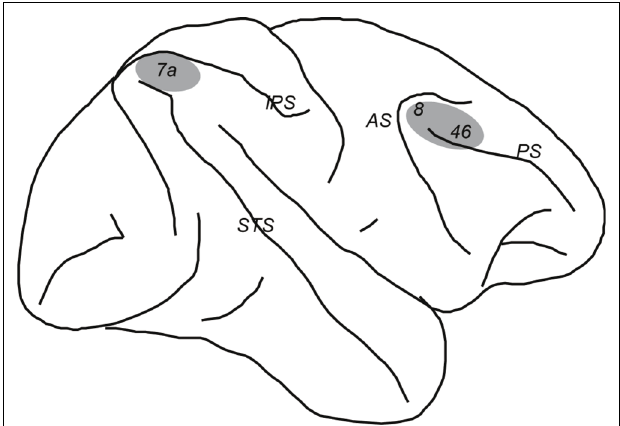
FIGURE 1 | Schematic diagram of the monkey brain. Areas were the recordings were performed are highlighted in gray. Abbreviations: AS, Arcuate Sulcus; IPS, Intraparietal Sulcus; PS, Prinsipal Sulcus; STS, Superior Temporal